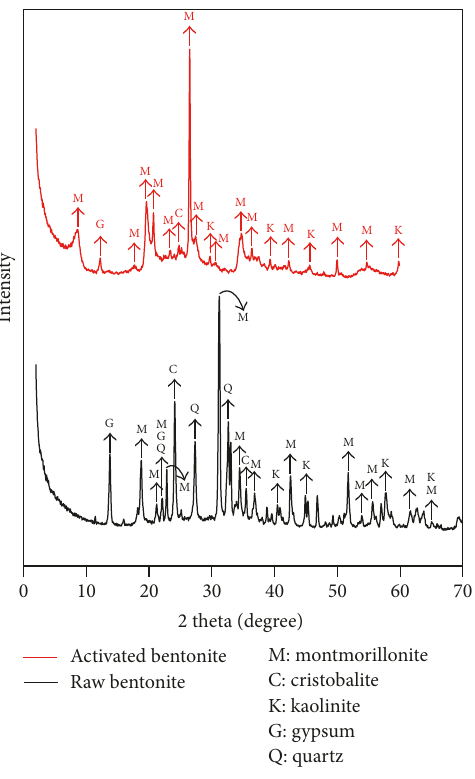
Figure 2: X-ray diffractograms of raw and acid activated Jordanian bentonite.